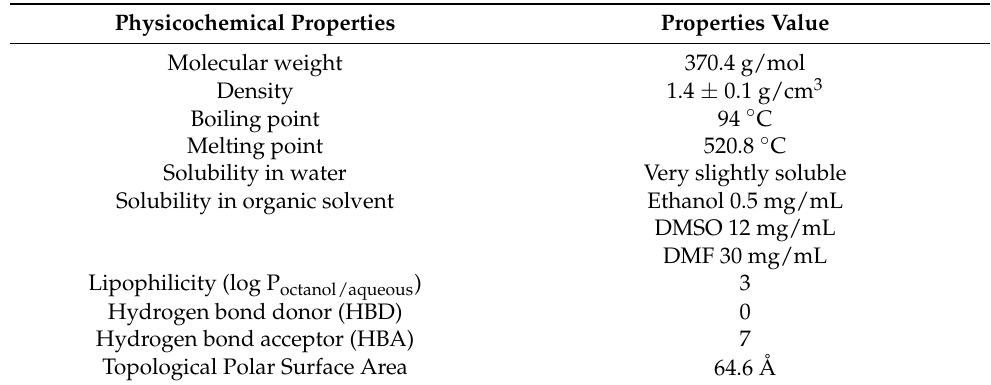
Table 2. Physicochemical properties of